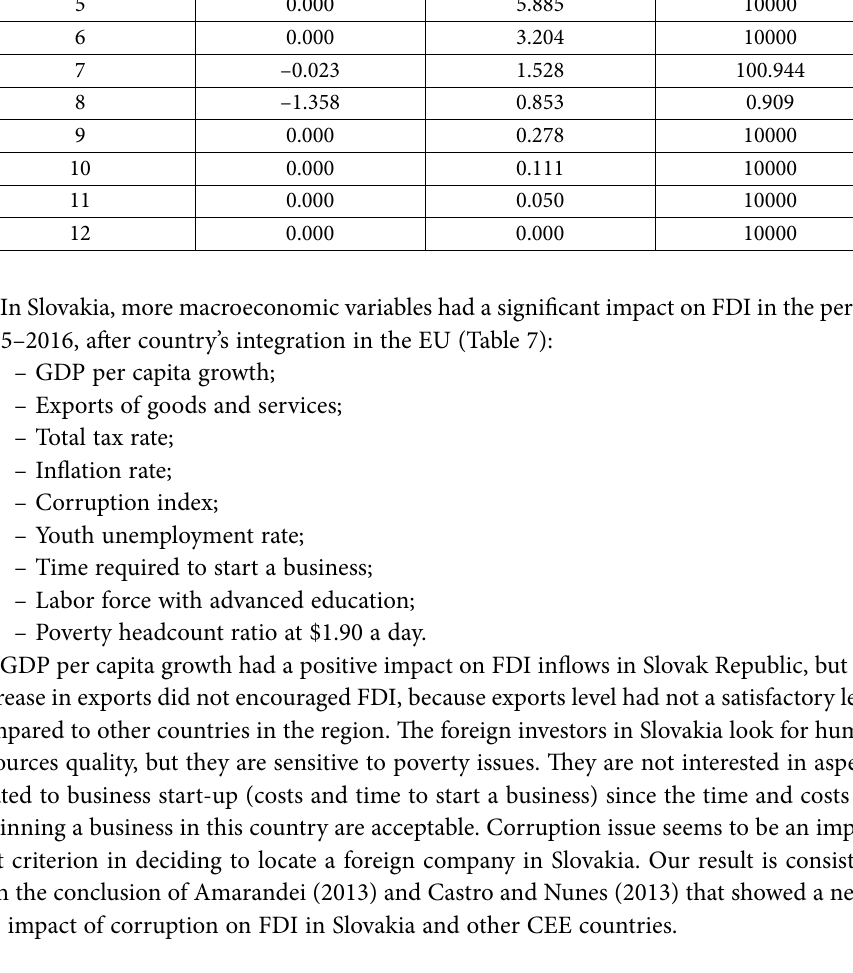
Table 7. Marginal posterior summary estimates for generalized ridge regression in case of Slovak Re- public (source: own results)